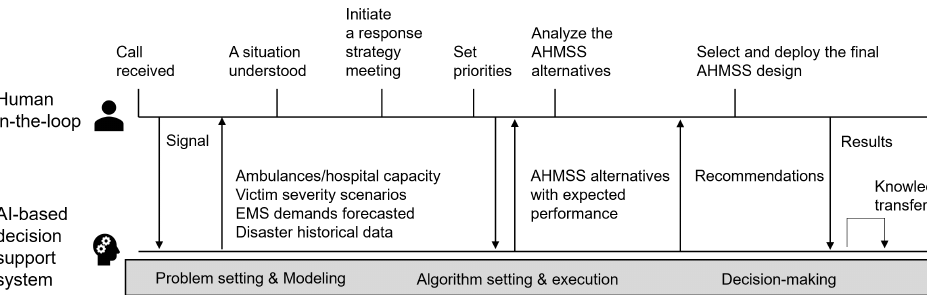
Figure 6. An example disaster response scenario with an AI-based decision support system.